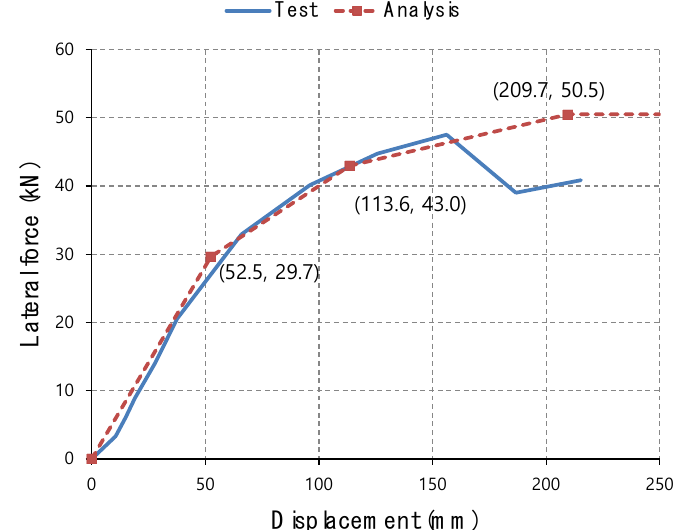
Figure 24. Validation of the analysis model for IC_OB_F specimen.